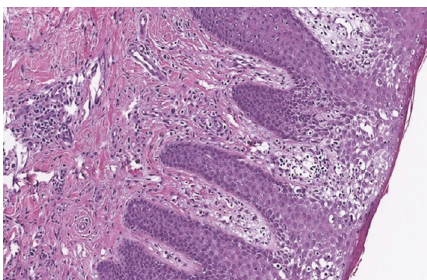
Figure 4: H&E stain of biopsy specimen taken at tumor of right thigh at 10x magnification. A dense dermal atypical lymphoid infiltrate with epidermotropism of atypical lymphocytes into the